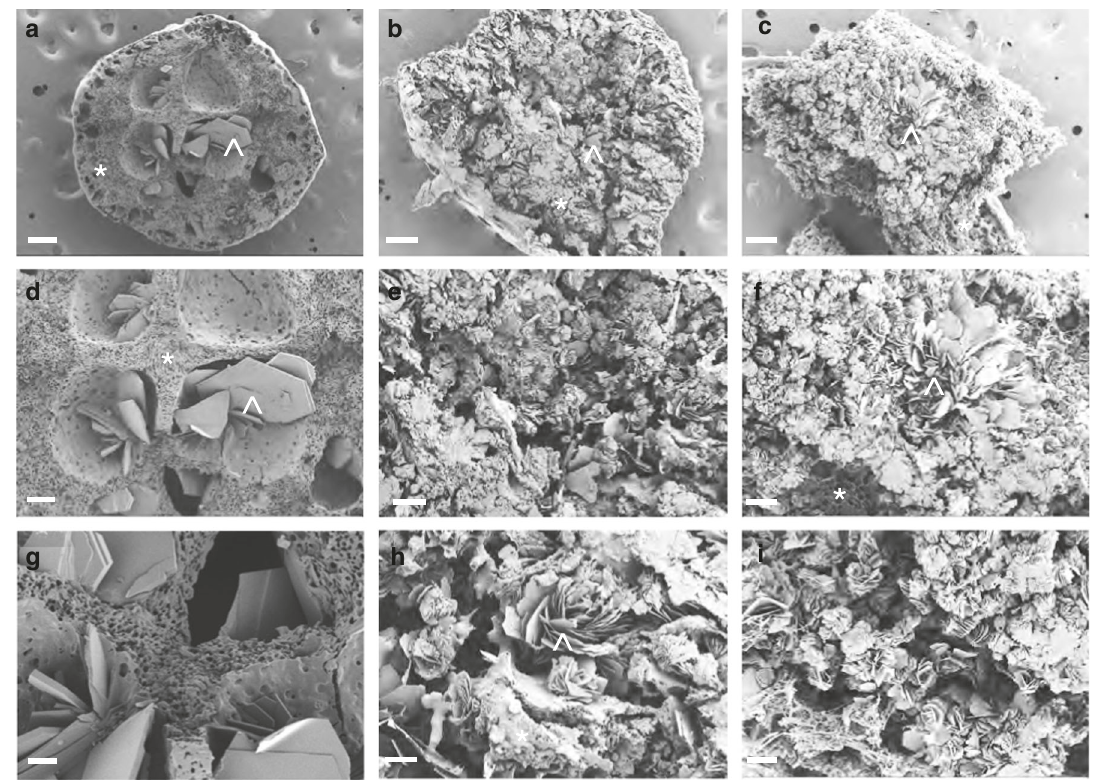
Fig. 3 Effect of PLGA/NMP ratio on the microstructure of the DTG implants. SEM cross-section images of DTG-ISFIs after drug release for 30 days ( n = 3). Each column is a representation of ISFIs containing a different ratio of PLGA to NMP. a , d , g 1:2 w/w PLGA/NMP ratio, b , e , h 1:4 w/w PLGA/NMP ratio, and c , f , i 1:8 w/w PLGA/NMP ratio. Row 1 ( a , b , c ) is a low magni fi cation image (×100, scale bar = 100 µ m) of the entire implant, Rows 2 (d , e , f ) and 3 (panels g , h , i ) are higher magni fi cation images (×200 , and ×500 , respectively, scale bar = 50 µ m, 20 µ m) focusing on the center of the implant. a 1:2 PLGA/NMP ×100 , b 1:4 PLGA/NMP ×100 , c 1:8 PLGA/NMP ×100 ( a – c scale bar = 100 µ m), d 1:2 PLGA/NMP ×200, e 1:4 PLGA/NMP ×200 , f 1:8